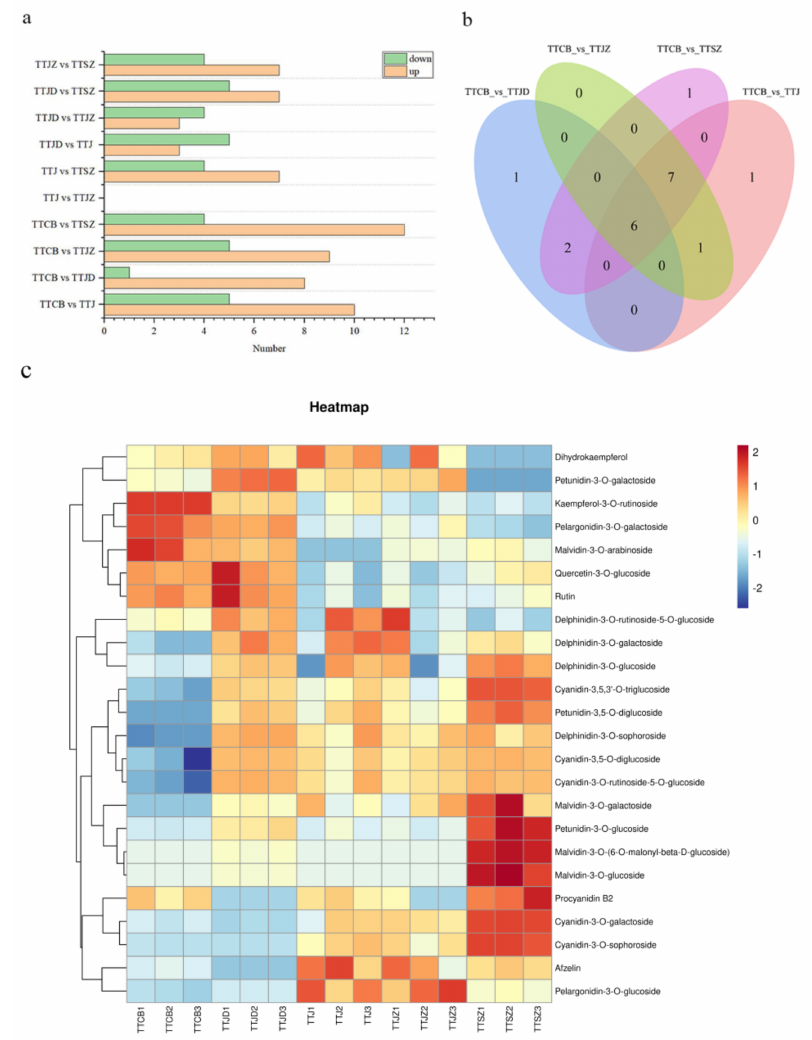
Figure 4. Analysis of the differentially accumulated metabolites. ( a ) Comparison of the metabolite profiles among different flower colours. The metabolites with increased levels are presented in red, and the metabolites with decreased levels are presented in black. ( b ) Venn diagram of differentially accumulated metabolites. ( c ) Heatmap of differentially accumulated metabolites.